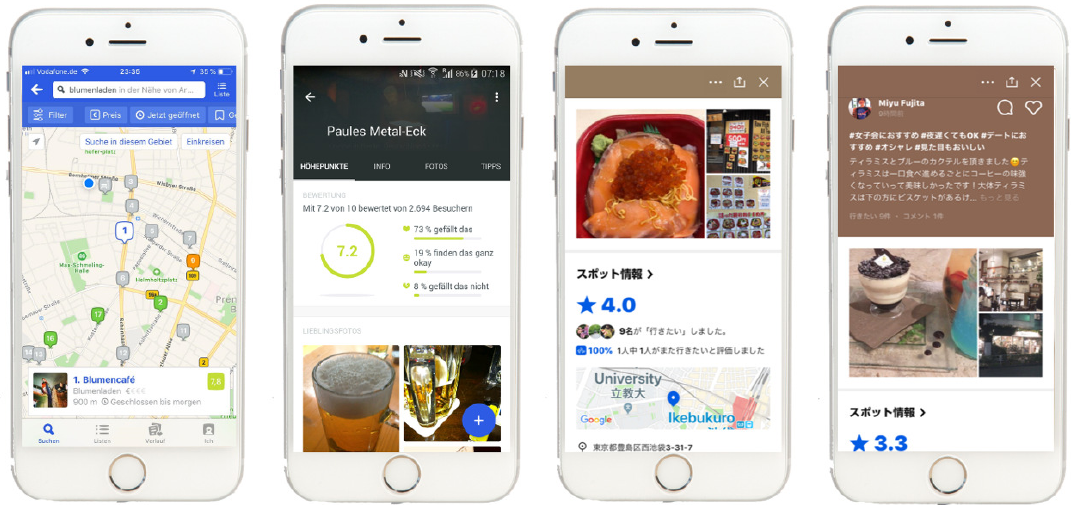
Figure 2. Screenshots of Foursquare City Guide (left) and Tabelog (right) captured in our interviewees’ media diaries. Media and Communication, 2021, Volume 9, Issue 3, Pages